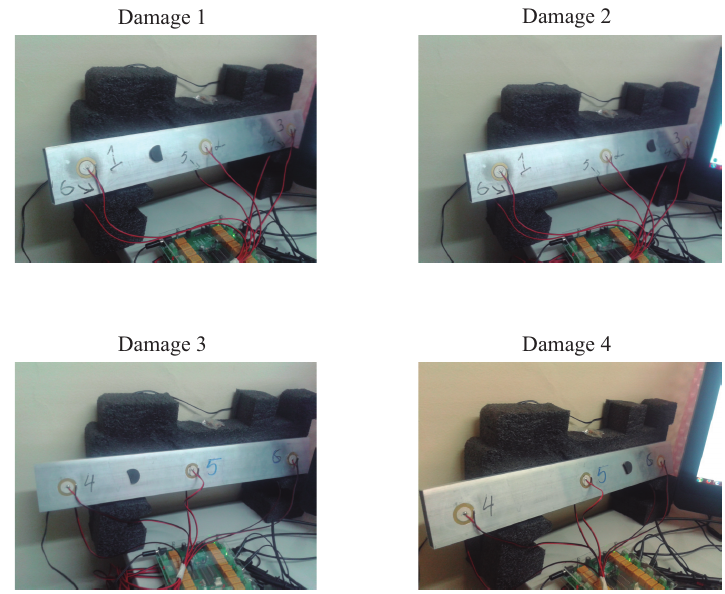
Figure 13. Aluminum rectangular profile instrumented with six piezoelectric sensors and with four different